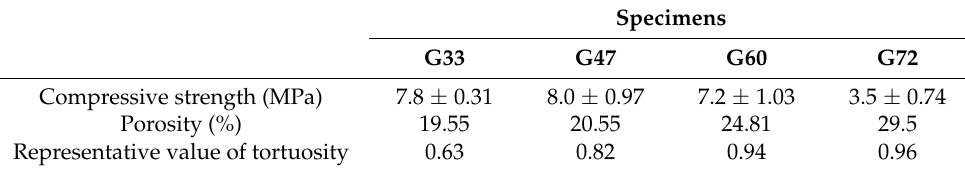
Figure 12. Correlation analysis between test variables: ( a ) effects of the weight ratio of #2 aggregate on the porosity and tortuosity, and ( b ) effects of the porosity on the compressive strength and tortuosity. Table 4. Comprehensive test results including compressive strength, porosity, and